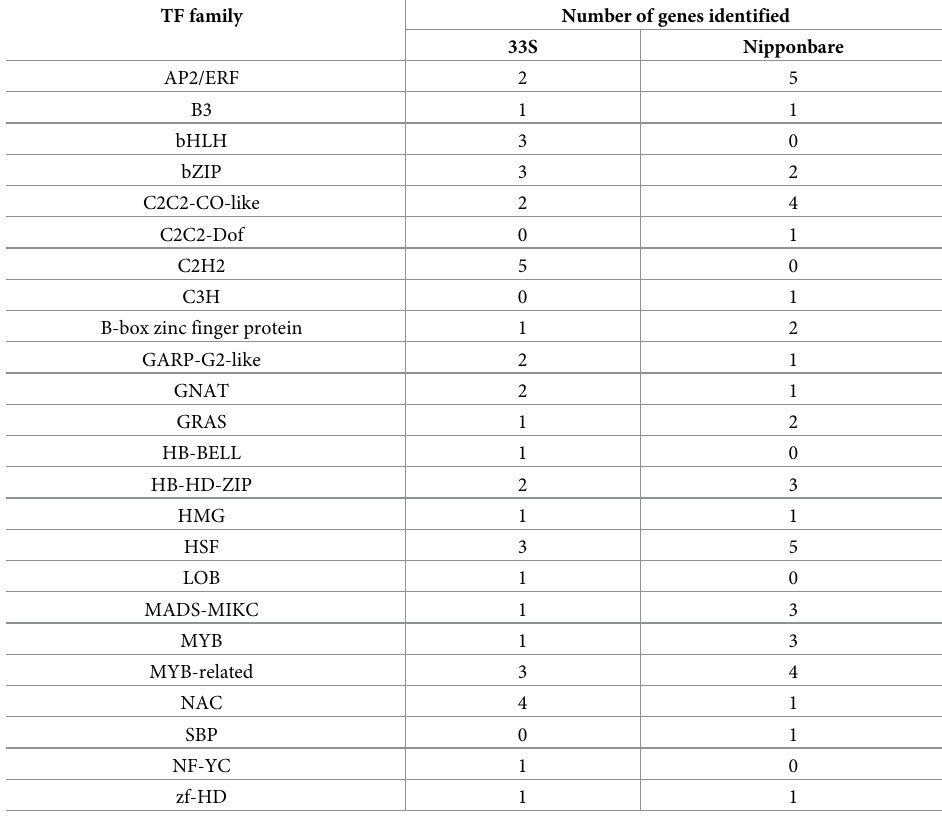
Table 3. Transcription factors response to low temperature treatment in 33S and